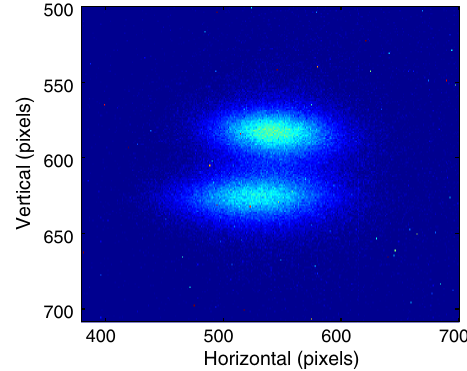
FIG. 15. X-ray pinhole camera image for the low-emittance lattices showing two stored electron beams at phases ’ ¼ (cid:6) (cid:1) ’ s and ’ ¼ ’ s